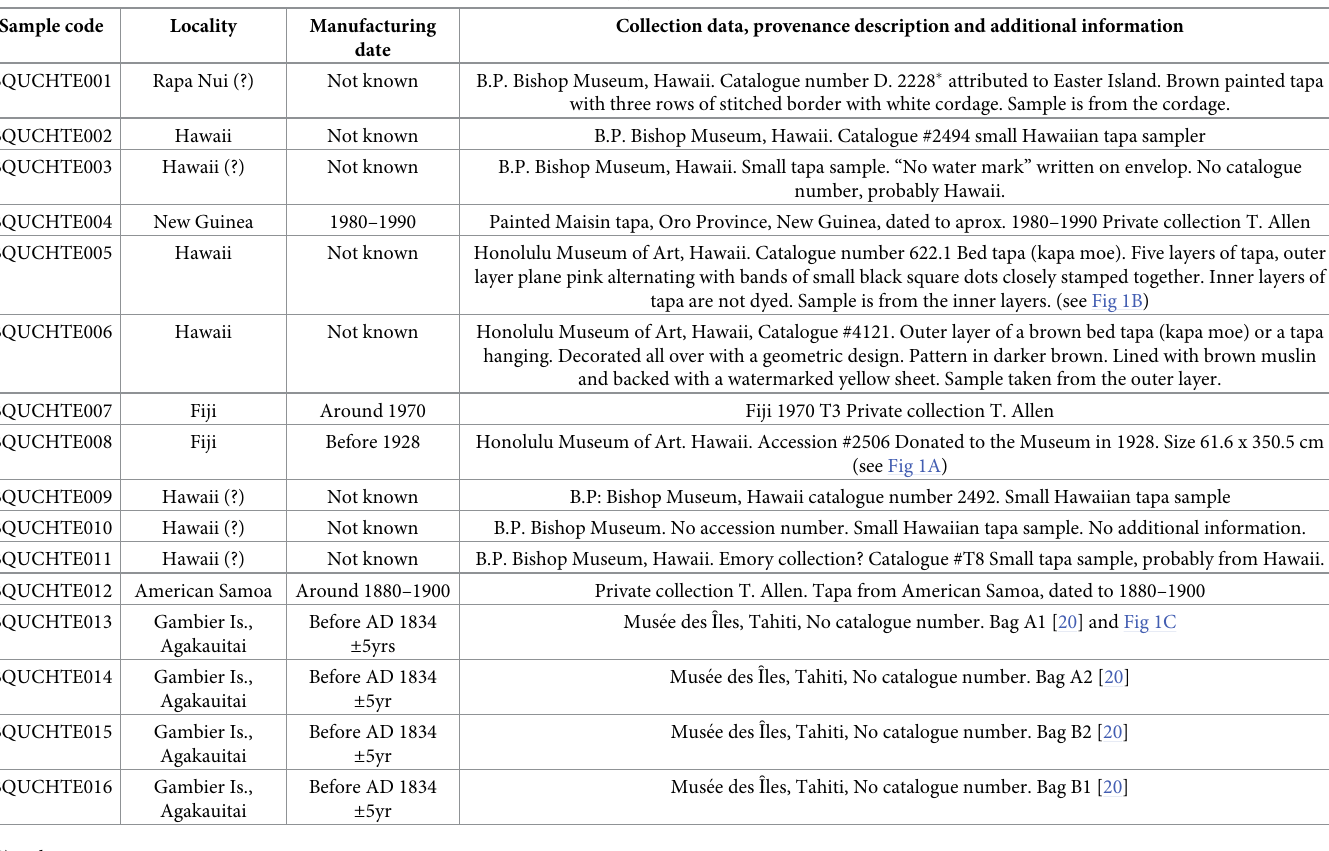
Table 1. Barkcloth textile samples included in this study. Sample code, locality, date of manufacture, and available data from the